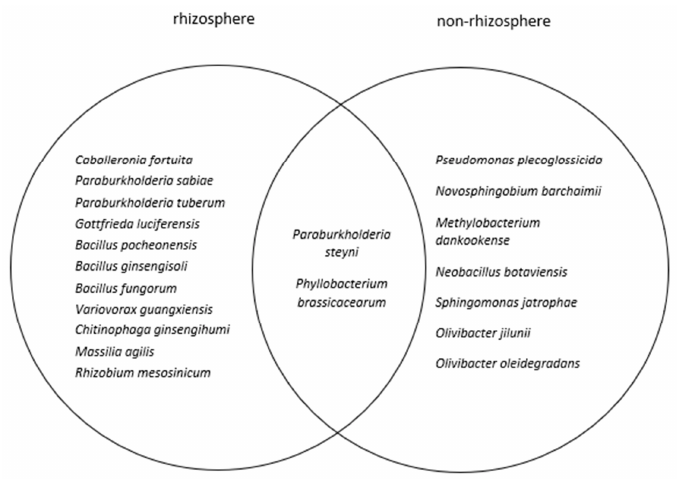
Figure 1. Venn diagram of bacteria shared between the rhizosphere and non-rhizosphere soils of E. natalensis . 2.3. Soil Enzyme Activities β -(D)-Glucosaminidase and acid phosphatase enzyme activity values were similar in the rhizosphere and non-rhizosphere soils (Table 5). Nitrate reductase enzyme activity was significantly higher in the rhizosphere than in the non-rhizosphere soils (Table 5). Alkaline phosphatase activity was higher in the non-rhizosphere soils than in the rhizo- sphere, although the difference was not significant statistically (Table 5) Table 5. Soil enzyme activities in the rhizosphere and non-rhizosphere soils of Encephalartos na- talensis growing in a disturbed savanna woodland ecosystem at Edendale, Pietermaritzburg in the KwaZulu-Natal (KZN) province of South Africa. Results are represented as mean ± SE. Differing letters show significant differences (independent sample t -test, p ≤ 0.05, n = 20).